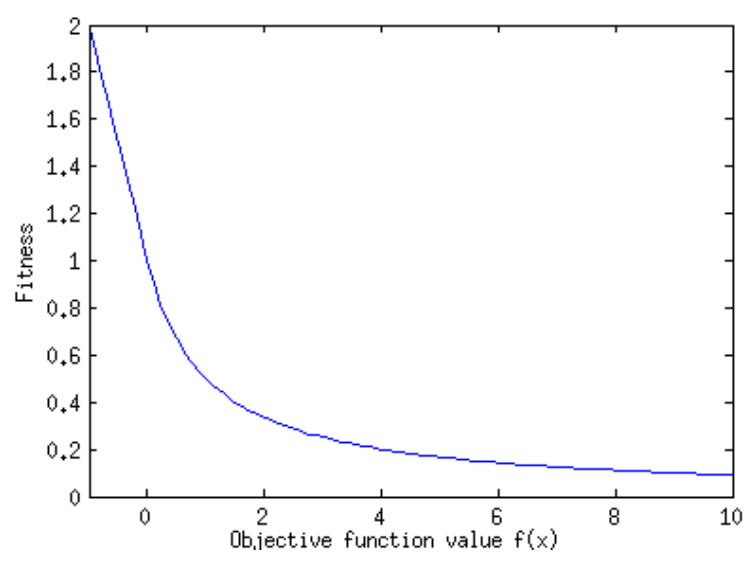
Figure 5. Relation between the fitness of a food source and objective function.